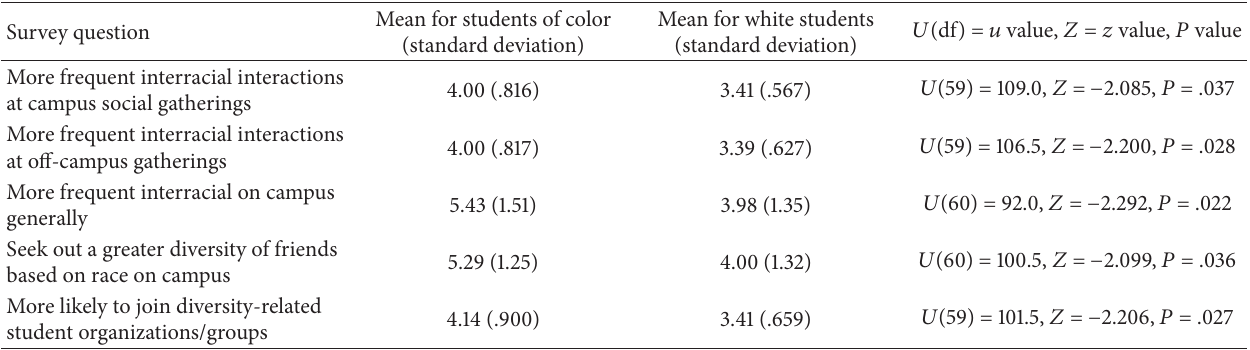
Table 3: Mean and Mann-Whitney 𝑈 test results (as a result of studying abroad . . .